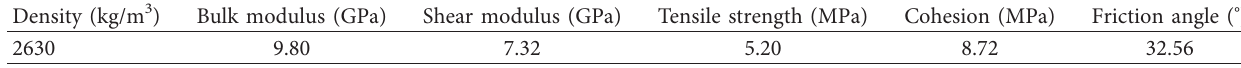
Table 4: Mechanical parameters of granite at a depth of